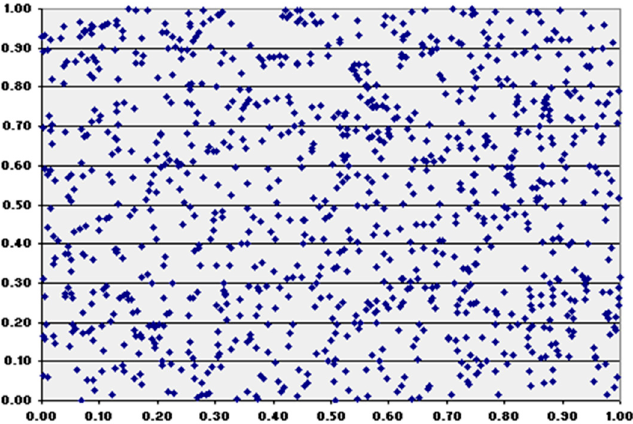
Figure 8. Random numbers after 1000 iterations.